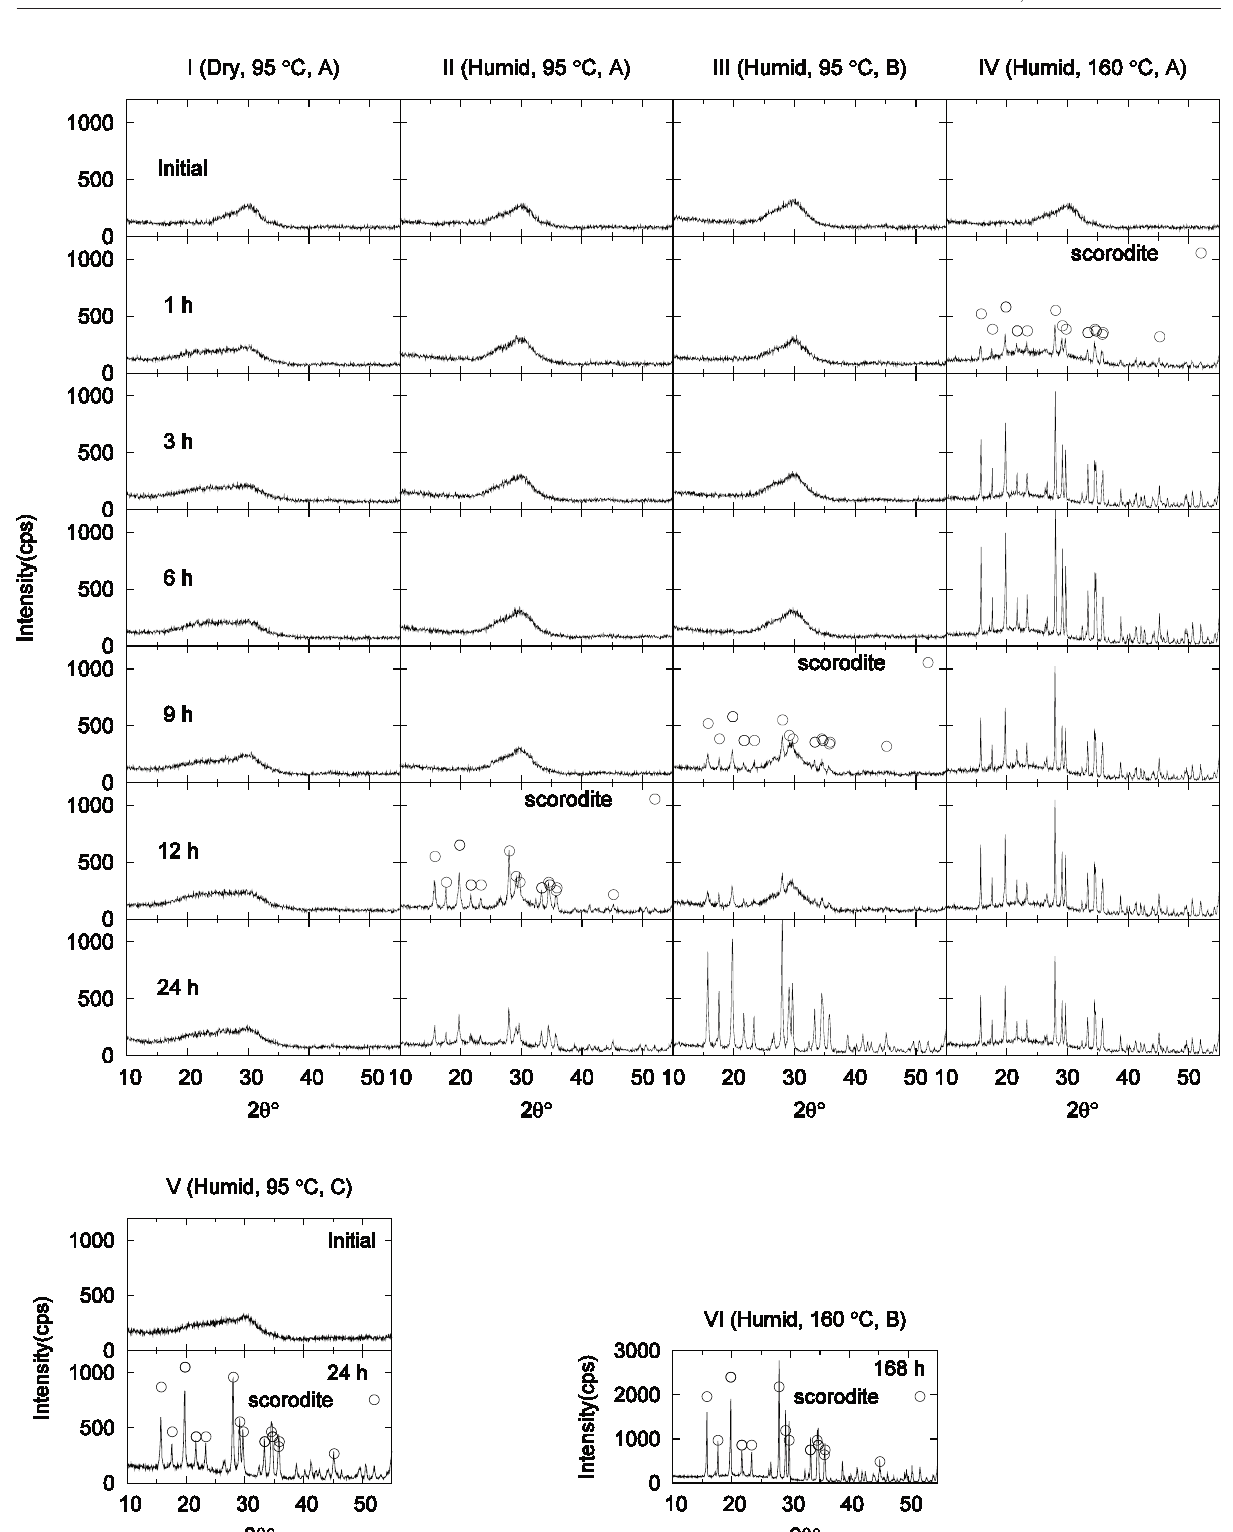
Figure 2. The XRD patterns of the samples obtained in all the experimental conditions and the retention